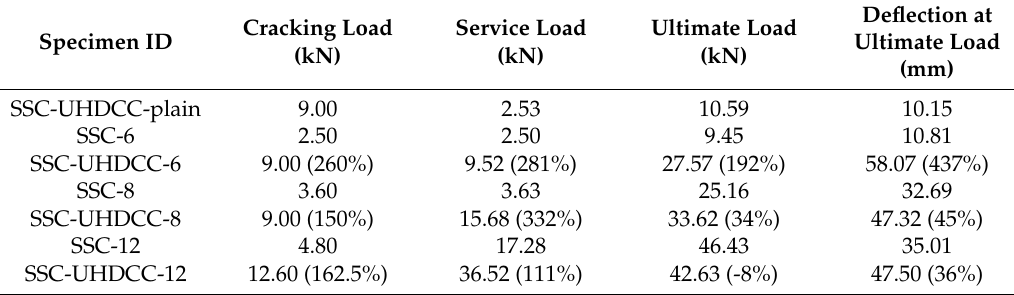
Table 7. Mechanical properties of tested beam.